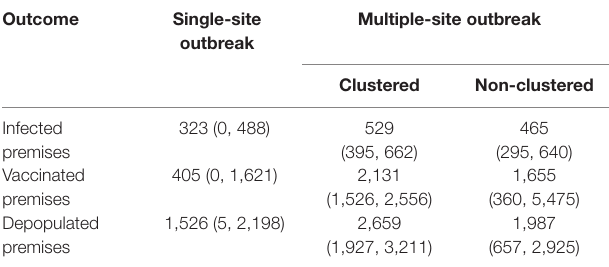
multiple-site outbreak scenarios.